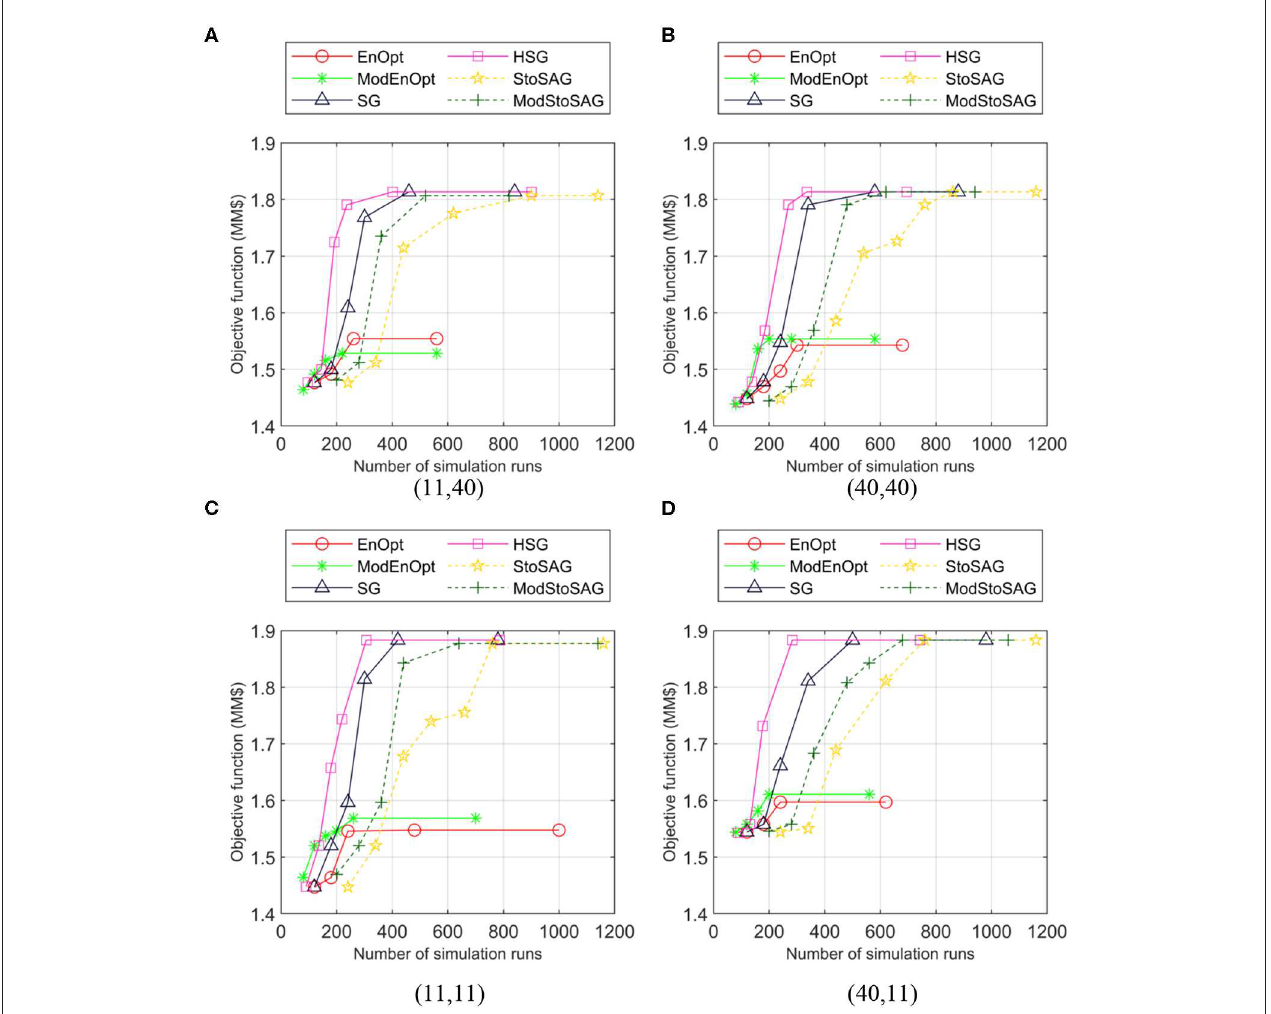
FIGURE 7 | Plot of numbers of simulation runs and objective function values of the six stochastic gradient methods for four initial solutions ( I and J locations). Symbols represent iterations, and the x -axis is the total number of simulation runs. (A) 1st initial solution (11,40). (B) 2nd initial solution (40,40). (C) 3rd initial solution (11,11). (D) 4th initial solution